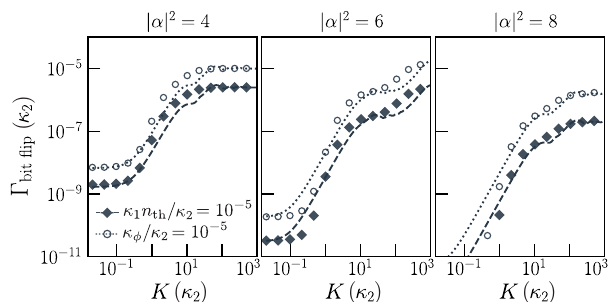
FIG. 3. Bit-flip error rate of an idle cat qubit confined by a combined Kerr and two-photon dissipation for increasing cat sizes. Both axes are graduated in units of κ 2 . The cat qubit is subject to single-photon loss of amplitude κ 1 = 10 − 3 κ 2 , with additional thermal excitation κ 1 n th = 10 − 5 κ 2 (diamonds, dashed lines) or pure dephasing κ φ = 10 − 5 κ 2 (circles, dotted lines). At low enough K , the exponential bit-flip suppression is restored. Markers indicate numerical simulation data, lines represent Eq.